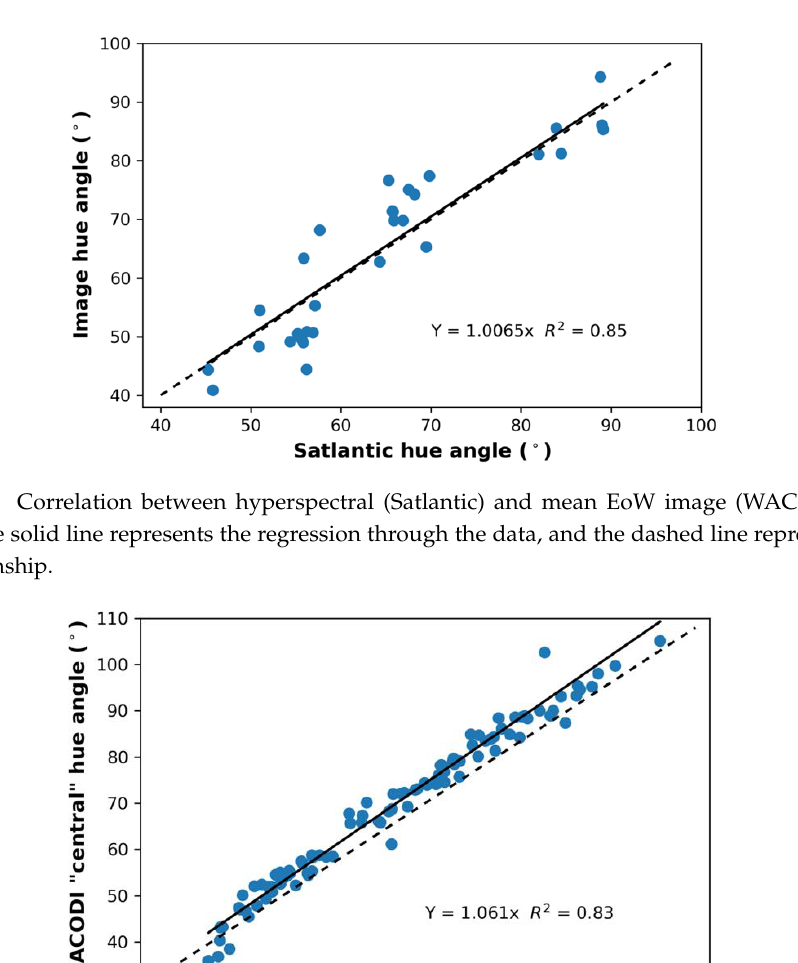
Figure 10. Correlation between hyperspectral (Satlantic) and mean EoW image (WACODI) hue angle. The solid line represents the regression through the data, and the dashed line represents the 1:1 relationship.